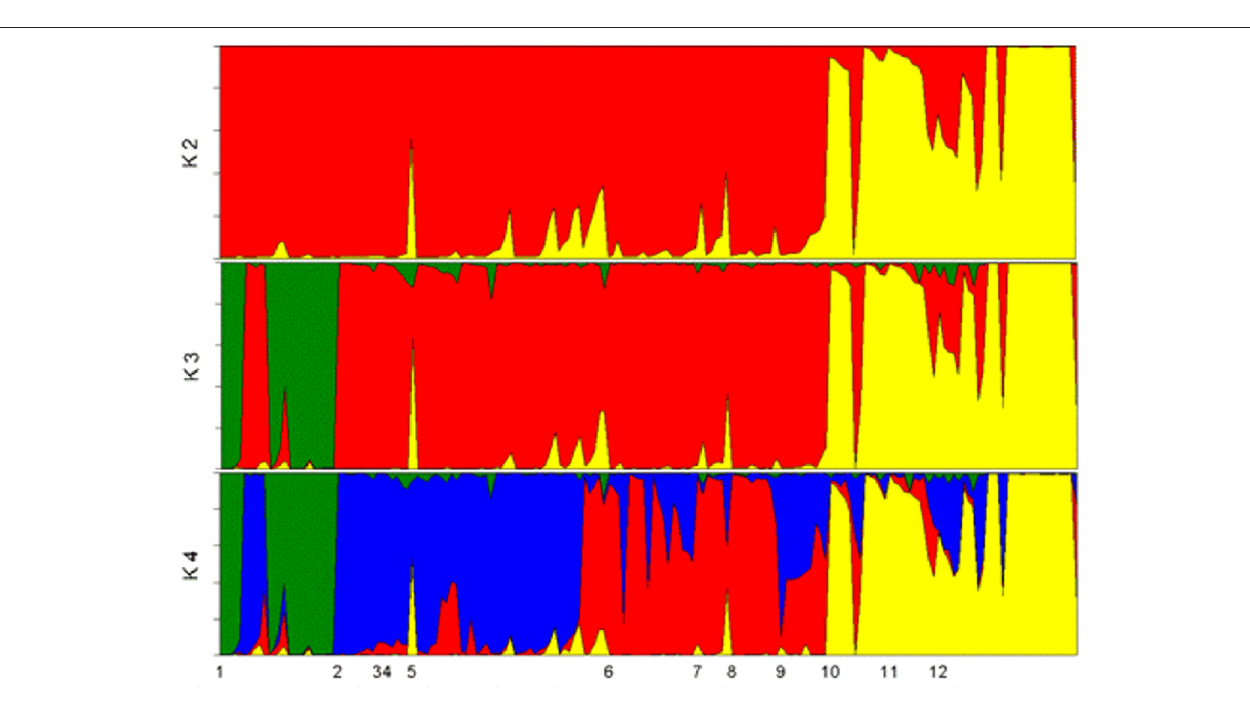
FIGURE 8 | Structure analysis of 173 peach palms ( Bactris gasipaes ) in 36 accessions of var. gasipaes and 4 accessions of var. chichagui in the Core Collection without prior information. Plants are organized by landrace and population from west (left) to east: 1, Utilis; 2, Cauca; 3, Pastaza; 4, Vaupés; 5, Putumayo; 6, Pampa Hermosa; 7, var. chichagui type 3; 8, Ucayali River; 9, Juruá; 10, upper Madeira River; 11, var. chichagui type 1; 12, Pará. (A) Group assignments for each palm for K = 2 groups. (B) Group assignments for each palm for K = 3 groups. (C) Group assignments for each palm for K = 4 groups, with yellow representing the southwestern to eastern Amazonian populations, red the southern western Amazonian populations, blue the northern western Amazonian populations and green the Central American